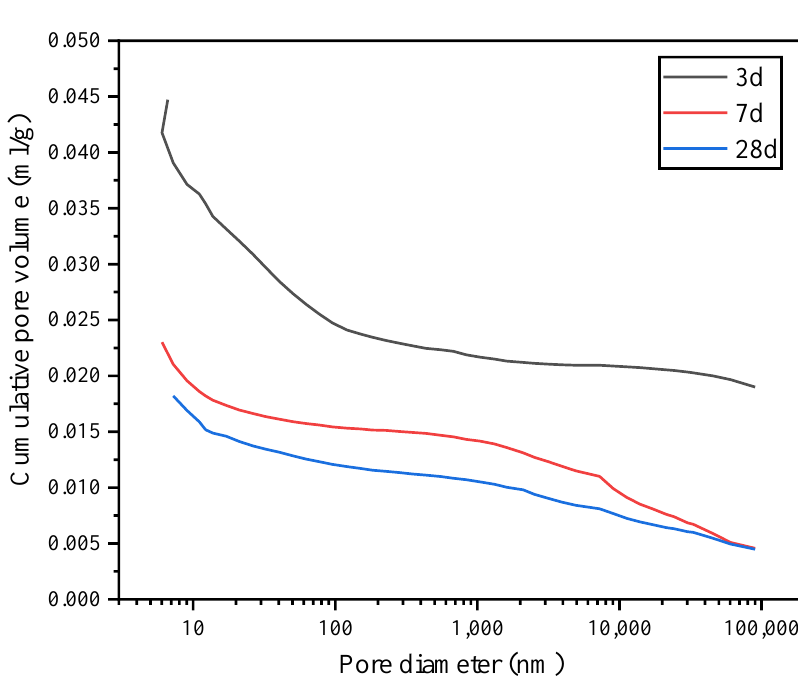
Figure 13. Cumulative pore volume of the G1 sample.